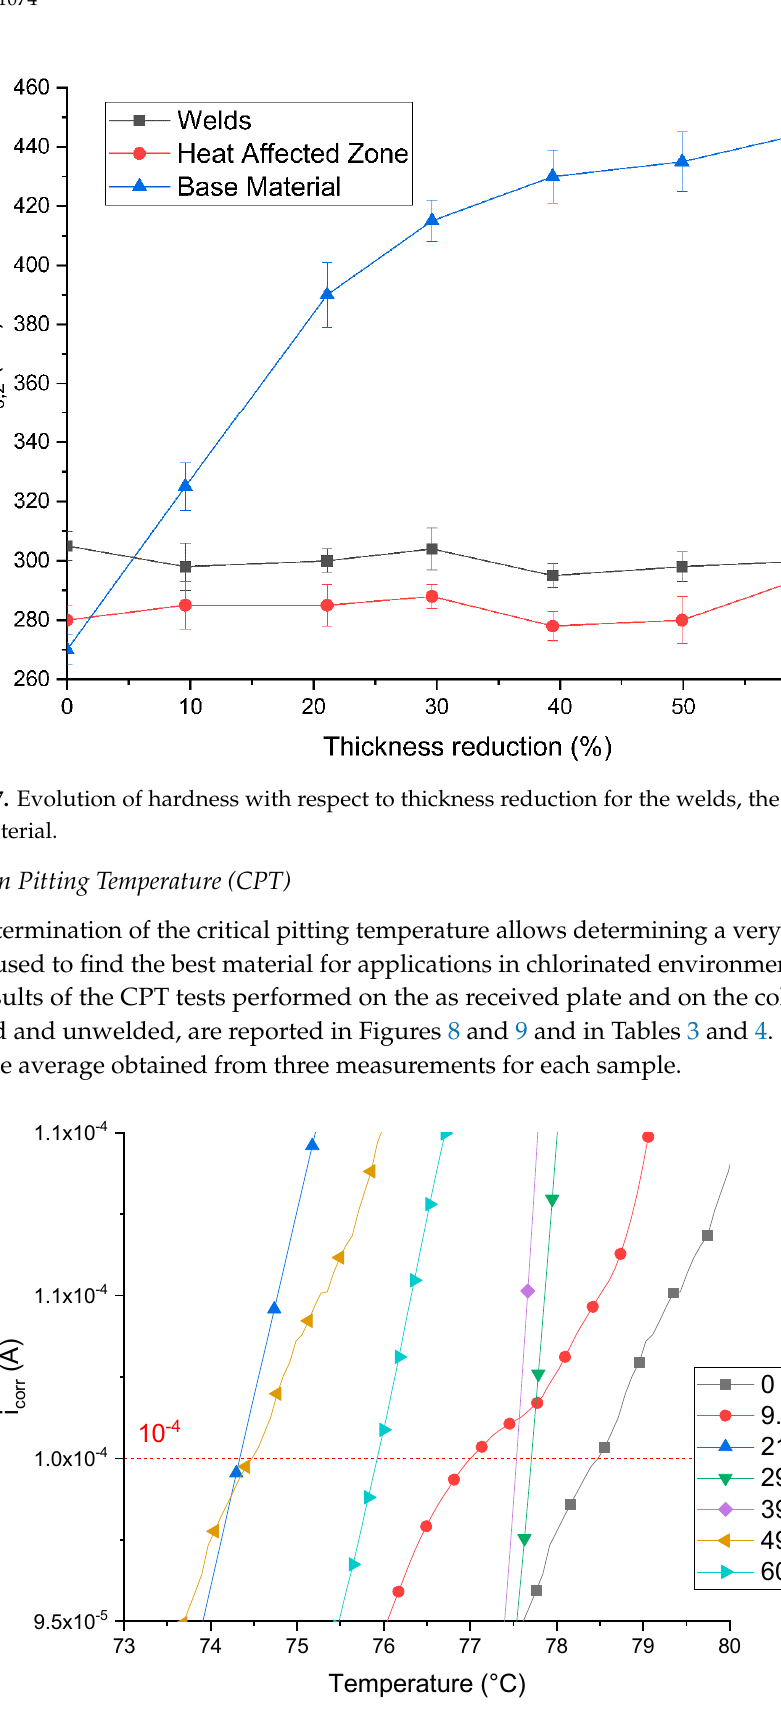
Figure 9. CPT curves of unwelded sheet metal.